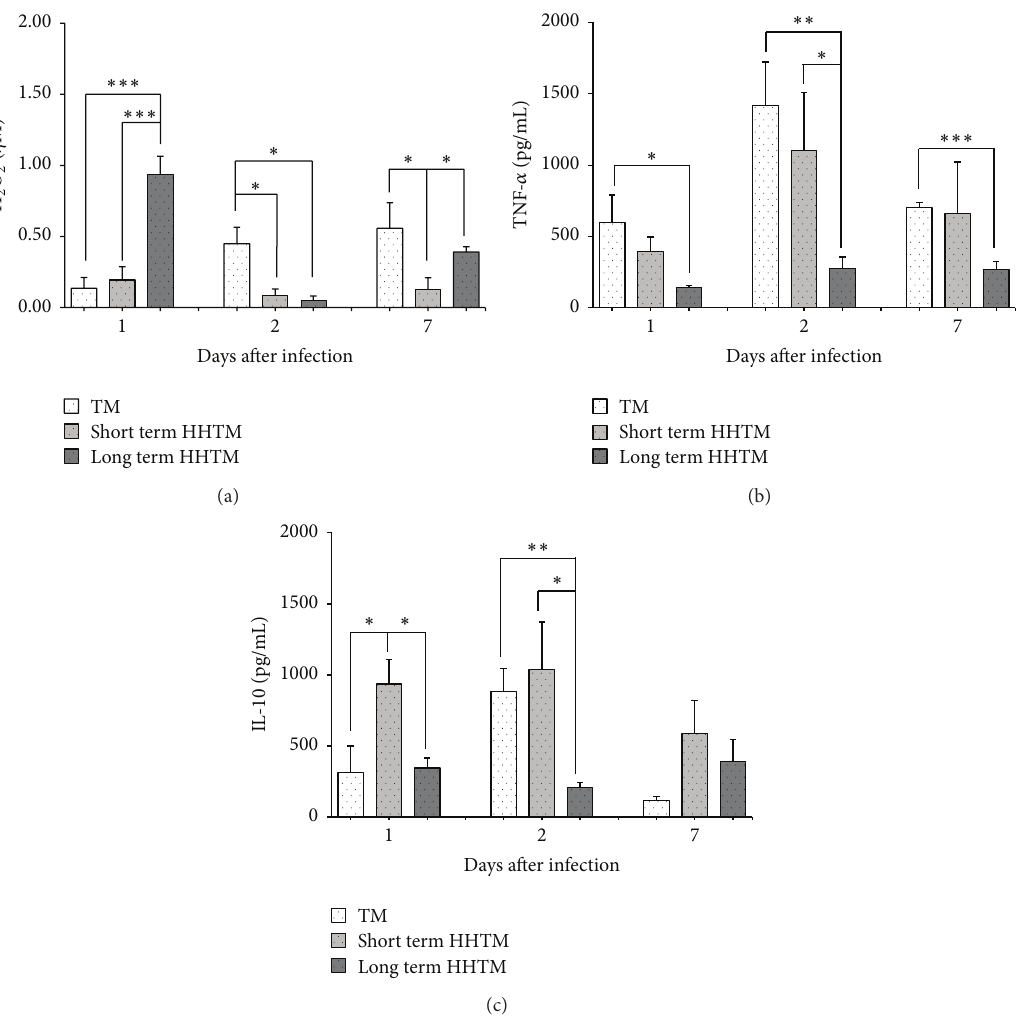
Figure 5: The hydrogen peroxide (H 2 O 2 ) (a), tumor necrosis factor- (TNF-) 𝛼 (b), and interleukin- (IL-) 10 (c) production. Peritoneal adherent cells were analyzed at 1, 2, and 7 days after fungal challenge. Data are expressed as the mean ± SEM and are representative of two independent experiments ( 𝑛 = 5 - 6 mice/group). The comparison between TM and HHTM groups was performed using unpaired 𝑡 -test ( ∗ 𝑝 ≤ 0.05 , ∗∗ 𝑝 ≤ 0.01 , and ∗∗∗ 𝑝 ≤ 0.001